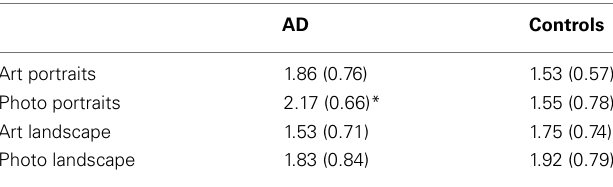
Table 2 | Esthetic stability forAD patients versus controls for each stimulus category.